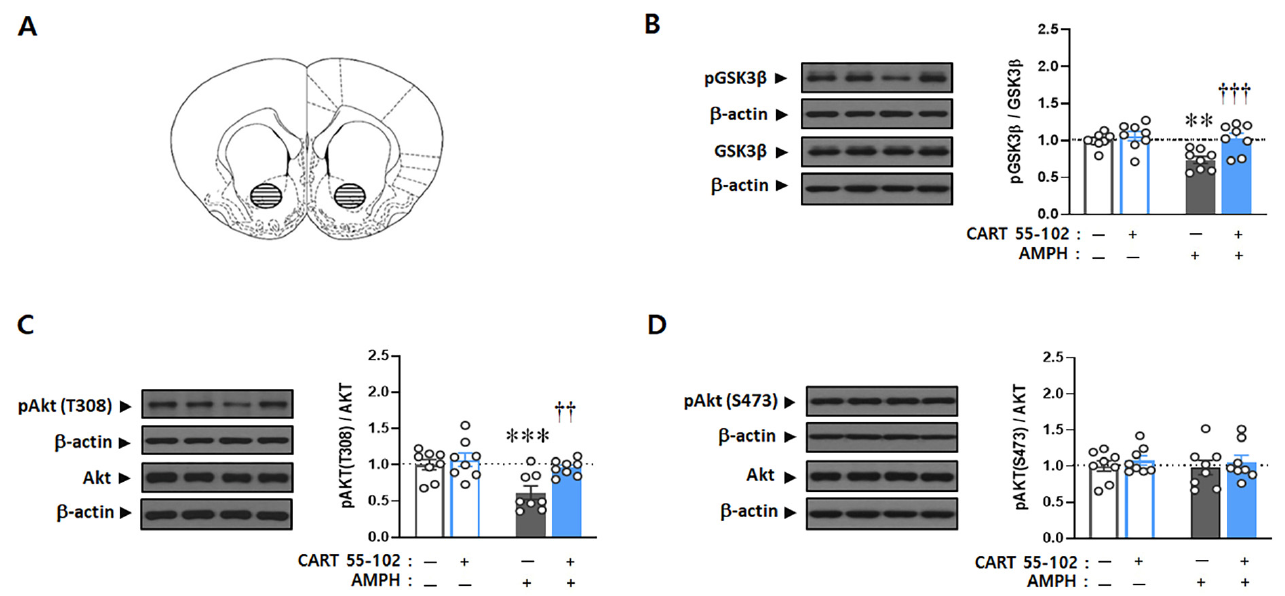
Figure 2. Microinjection of CART peptide 55–102 into the NAcc core inhibits the AMPH-induced decreases in phosphorylation levels of Akt (T308) and GSK3 β . ( A ) The NAcc core region where tissues were sampled is shown (cross-hatched circles). Punches (1.2 mm diameter) were prepared bilaterally and pooled for each animal’s protein isolation. The line drawing is from Paxinos and Watson [40] and depicts the caudal surface of a coronal section (1.0 mm thick) extending 1.70–2.70 mm from bregma. ( B – D ) Representative Western blots of total and phosphorylated forms of GSK3 β and Akt are shown. Values for the band intensities were first normalized to β -actin, and the average values for the ratio of phosphorylated to total proteins in each group are expressed as mean (+S.E.M.) relative to saline microinjection + saline IP injection group. Symbols indicate significant differences, as revealed by post hoc Tukey comparisons following two-way ANOVA. ** p < 0.01, *** p < 0.001, significant differences between saline microinjection. †† p < 0.01, ††† p < 0.001, significant differences within AMPH IP injection. The line drawings are adapted with permission from Paxinos and Watson [40]. The number of rats in each group is 8.